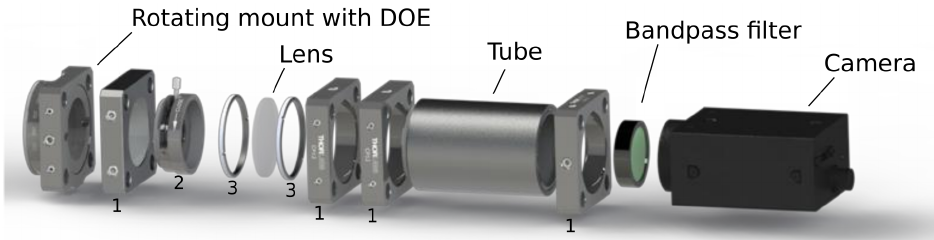
Figure 2. The imaging system is composed of a CGH, a lens with f (cid:48) = 200mm, an optical tube to reduce stray light, a bandpass filter and the camera. Other components: (1) cage plate, (2) lever- actuated iris, (3) SM1 retaining ring.